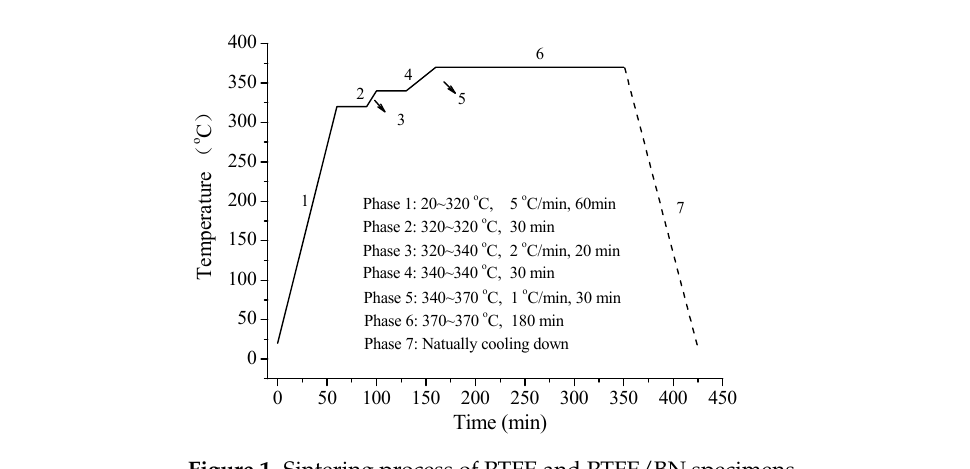
Figure 1. Sintering process of PTFE and PTFE/BN specimens.